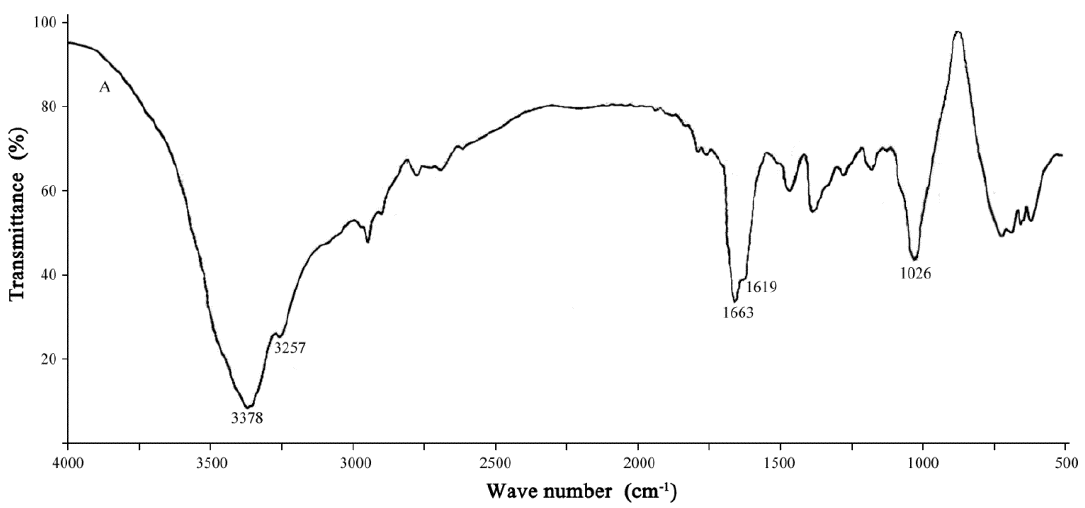
Figure 5. GPC analysis of PAM before and after biodegradation. ( A ) Chromatography of uninoculated control; ( B) chromatography of PAM after 7 days biodegradation.